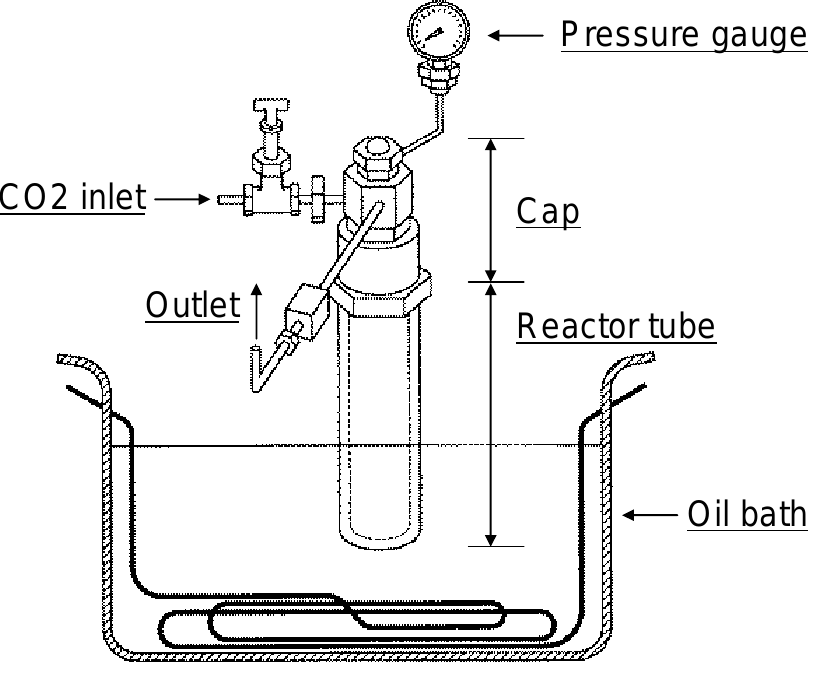
Figure 3. Diagram of the autoclave reactor for the supercritical CO